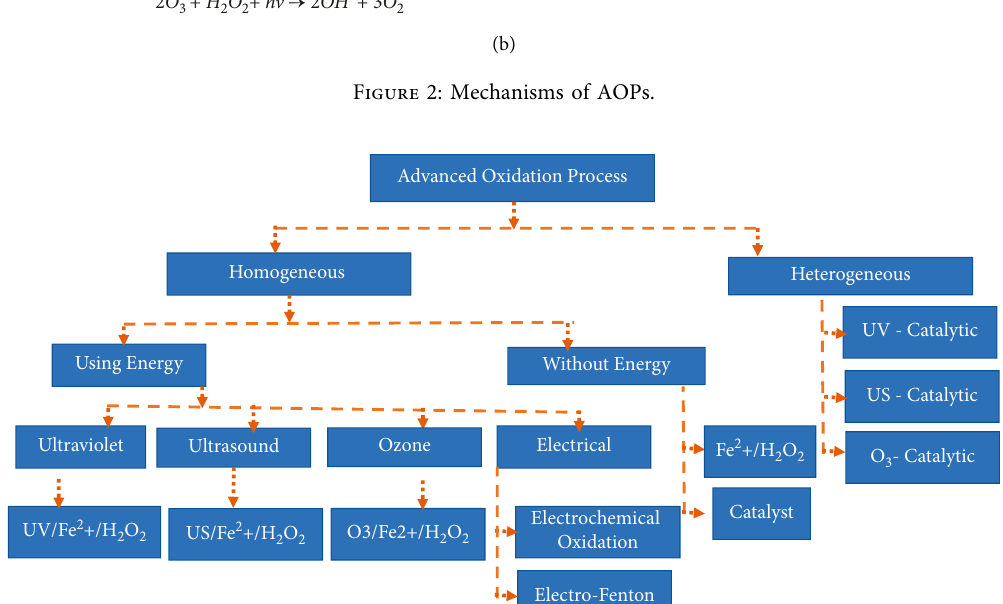
Figure 2: Mechanisms of AOPs.